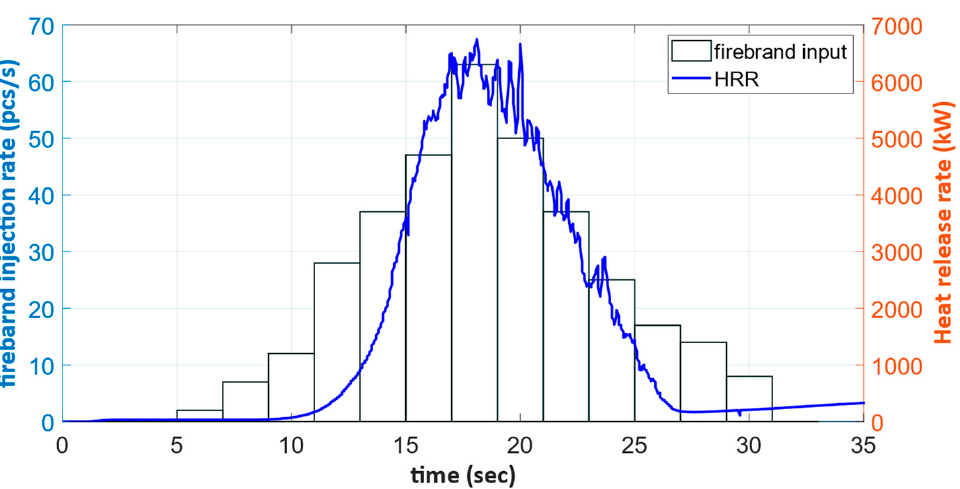
Figure 3. HRR of tree burning and the firebrand injection rate vs. time. The firebrand injection rate was adjusted according to the HRR.